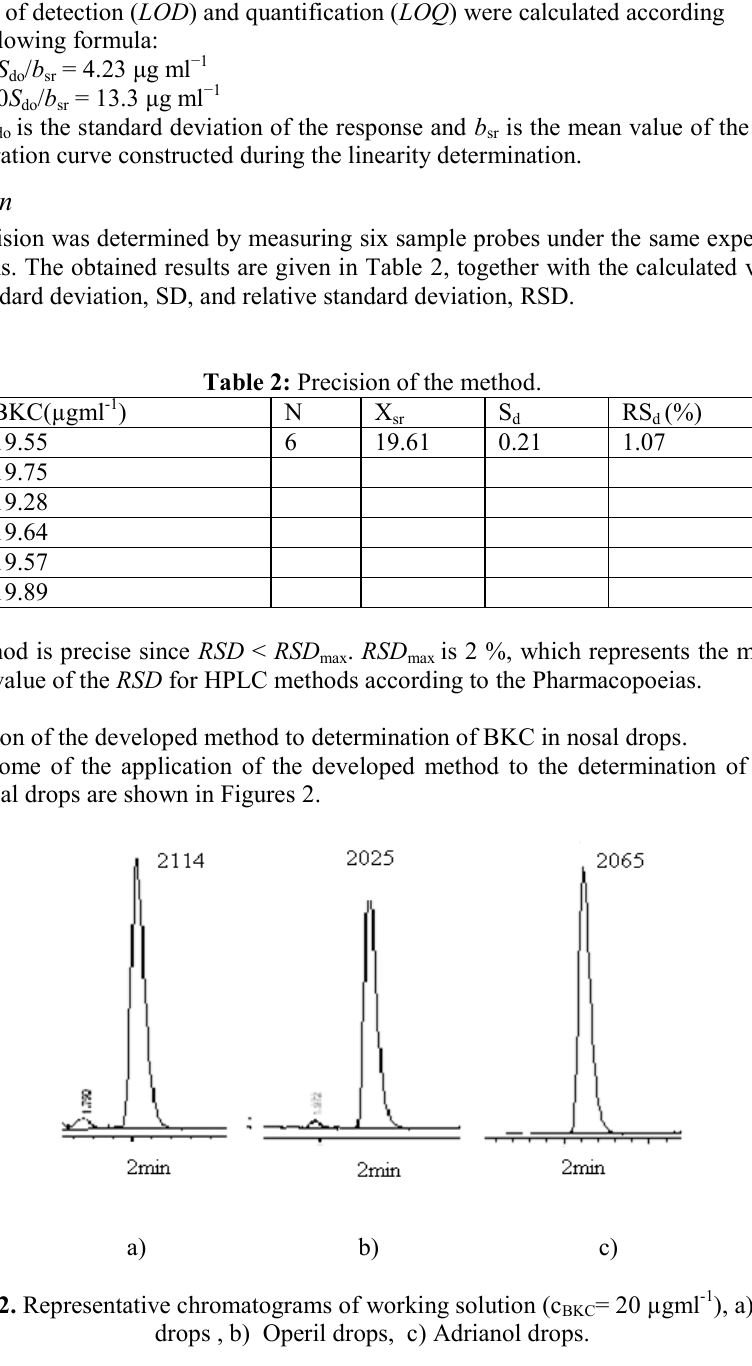
Figure 2. Representative chromatograms of working solution (c drops , b) Operil drops, c) Adrianol